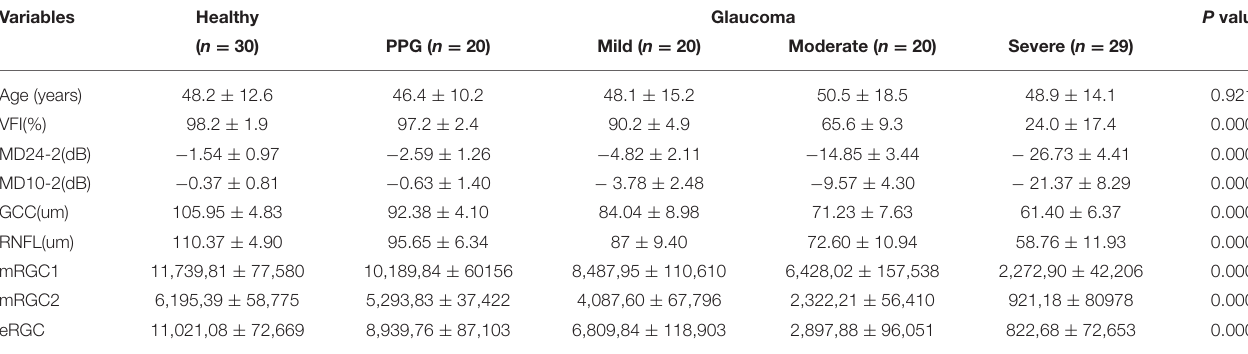
TABLE 1 | Demographic and clinical characteristics of healthy eyes and primary open-angle glaucoma (POAG) eyes in different stages. Variables